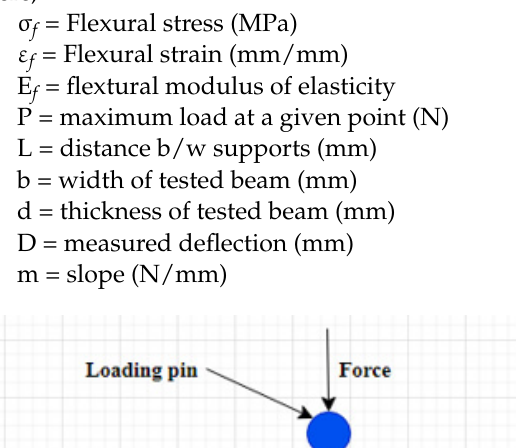
Figure 7. Microstructure Analysis (A Digitech ® 5MP USB Microscope Camera).